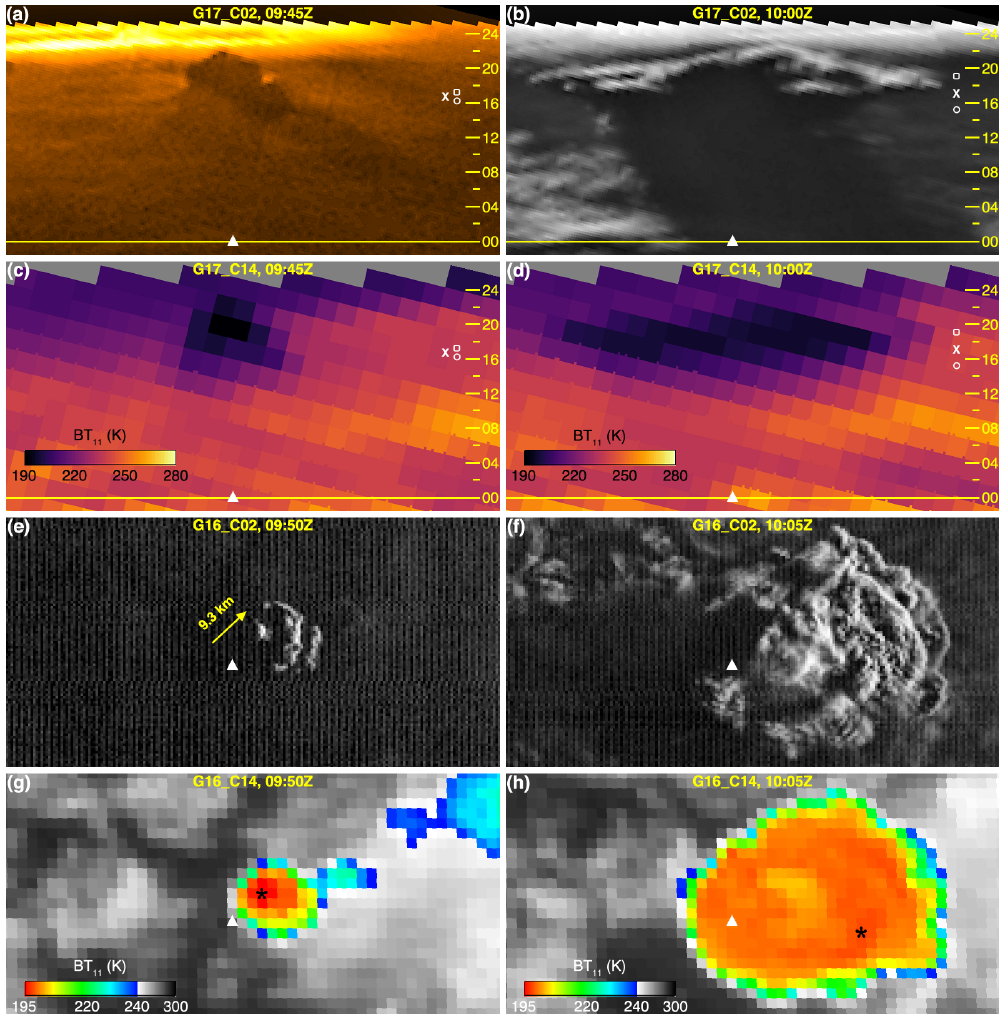
Figure 5. The eruption plume on 10 April 2021 at (left column) 09:45UTC and (right column) 10:00UTC in (top to bottom) GOES- 17 channel 2, GOES-17 channel 14, GOES-16 channel 2, and GOES-16 channel 14 imagery. The GOES-16 images are from the trailing ( + 5min) MESO2 scans. La Soufrière is marked by the white triangle, and the image in panel (a) was pseudocolored using the “Orange Hot” palette. In the GOES-17 side views, the yellow line is the baseline, the elevation markings indicate height in kilometers, and the white square, cross, and circle respectively depict the maximum, mean, and minimum plume heights derived from the GOES-16 dark pixel temperature, whose location is marked by the black star in panels (g) and (h) . In panel (e) , the arrow indicates the ellipsoid-projected distance between the volcano and the overshooting top along the GOES-16 view azimuth of − 133 ◦